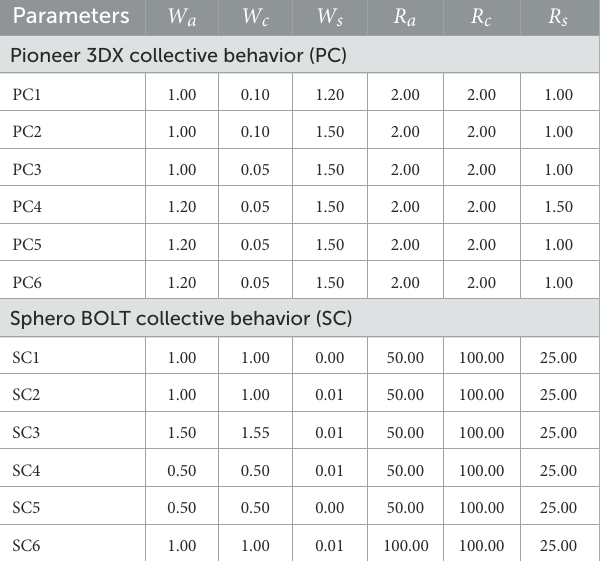
TABLE 2 Parameters for hand-crafted collective behaviors of Pioneer 3DX robots (Abpeikar et al., 2022a) and Sphero BOLT robots. Parameters